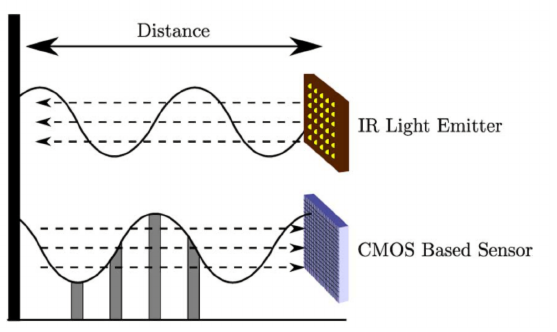
Figure 3. Time-of-Flight distance measurement